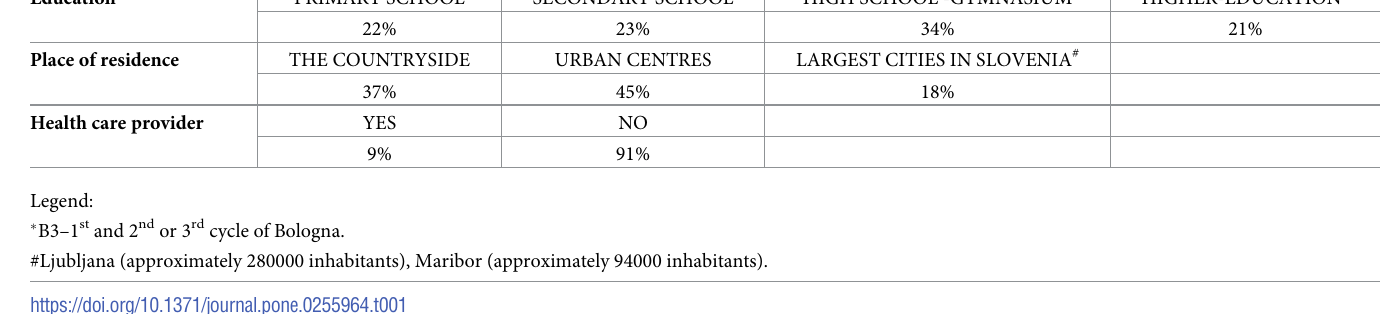
years also assessed itself with a statistically significantly (p < 0.05) higher mean score than the oldest age group. Three quarters of all respondents knew the correct emergency telephone number, which was a three-fold larger proportion in comparison with the knowledge of the correct ratio of chest compressions and rescue breaths during resuscitation and about a 1.5 larger proportion compared to the knowledge of the correct measures in case of partial airway obstruction (see Table 2). In the oldest ( > 60 years) age group, the proportion of the respondents who knew the emergency telephone number was almost 20% lower than in the youngest age group, which was statistically significantly different ( χ 2 = 14.318; p = 0.003). In the oldest group, the